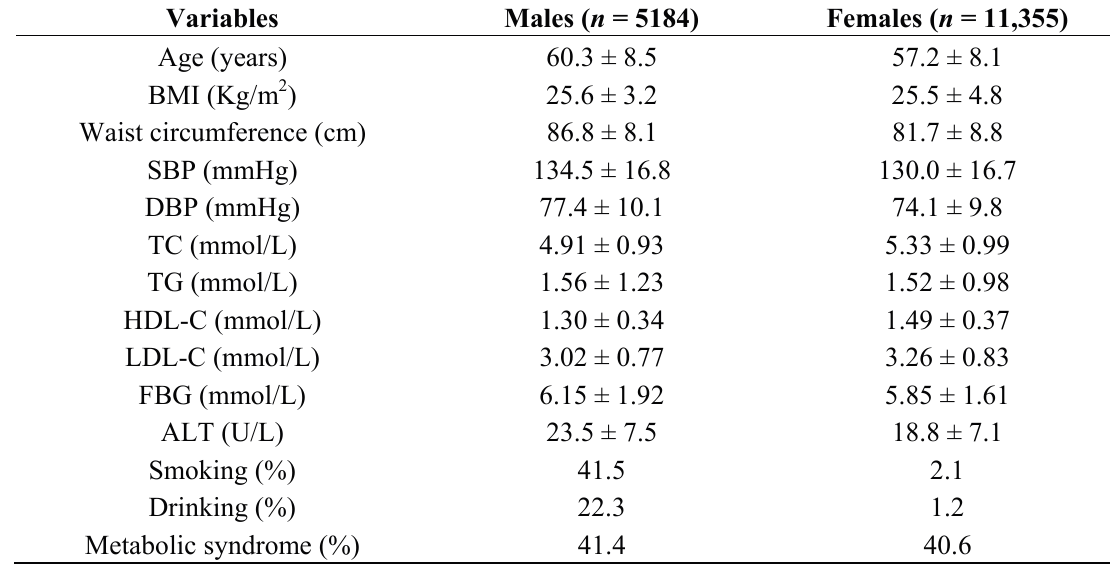
Table 1. General characteristics of population.